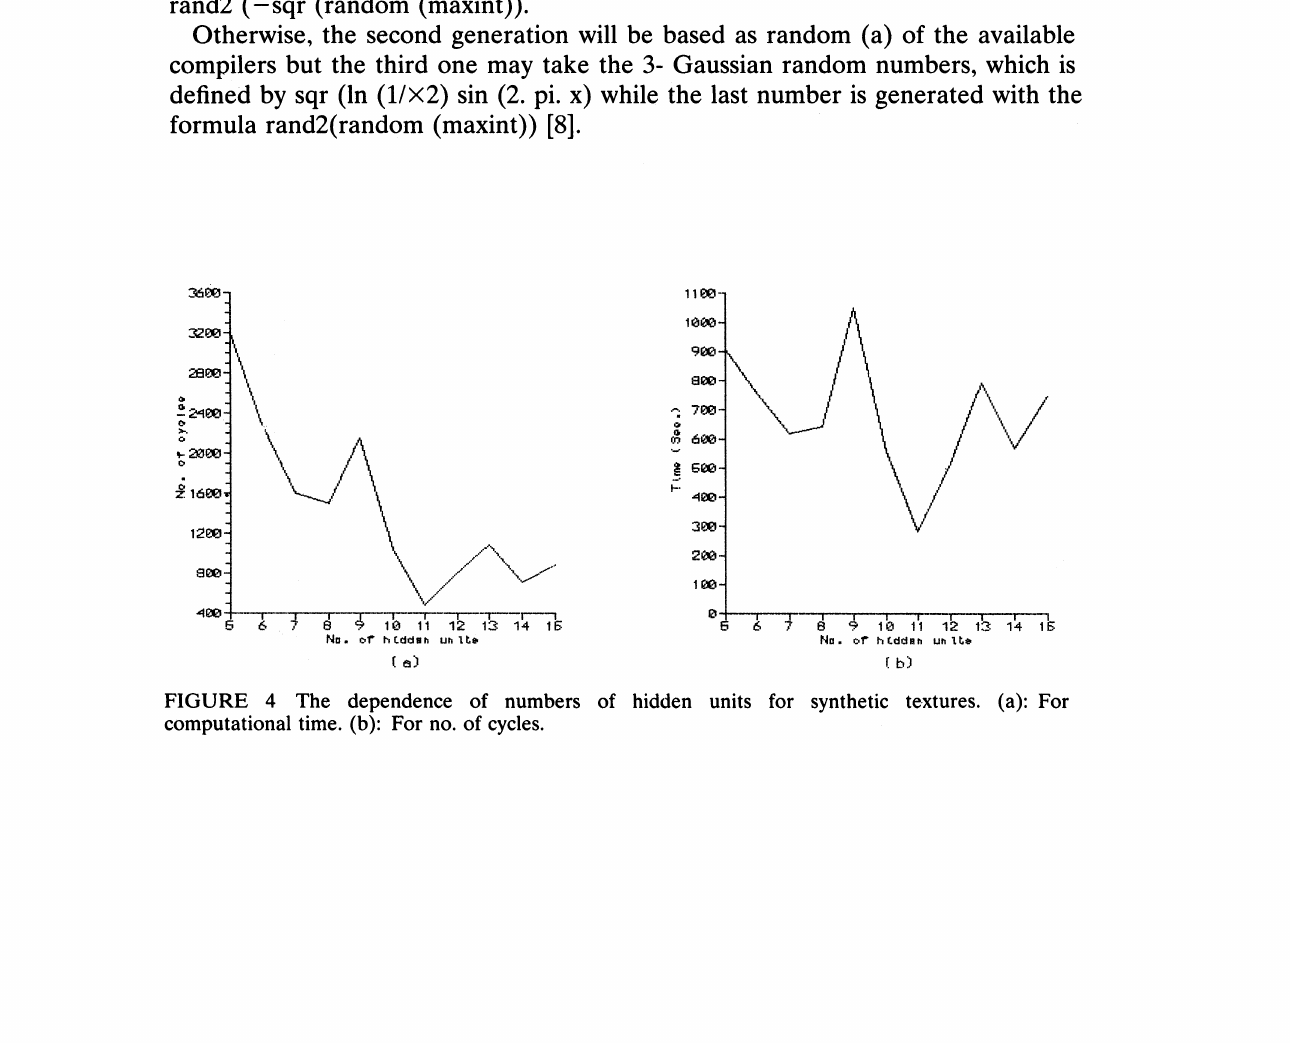
FIGURE 4 The dependence of numbers of hidden units for synthetic textures. (a): For computational time. (b): For no. of